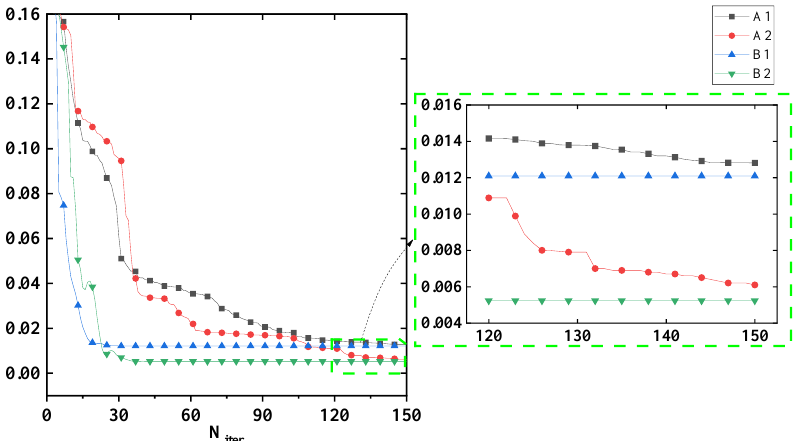
Figure 5. Convergence of the four algorithms for the case of sigma = 0.3 pixels in Table 1. We can see that the parametric algorithms (B1, B2) with an analytic partial derivative of E with respect to an aberration coefficient 𝛼 𝑗 have a higher convergence efficiency.